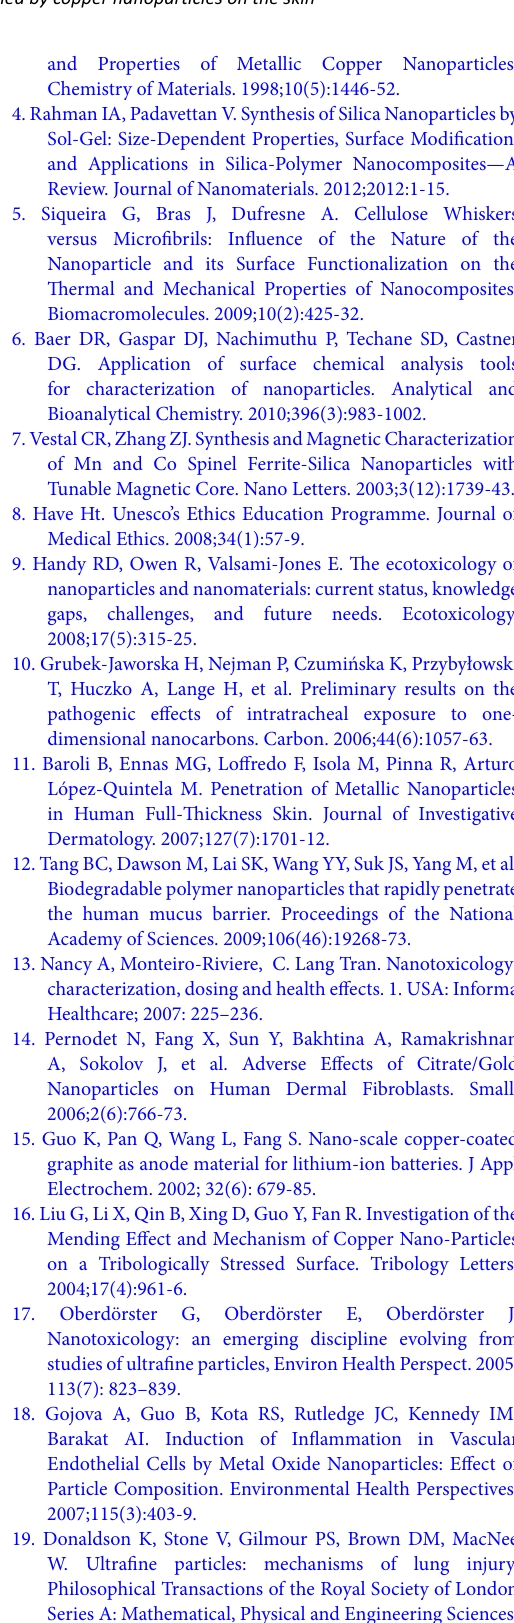
184 Nanomed Res J 4(3): 176-185, Summer